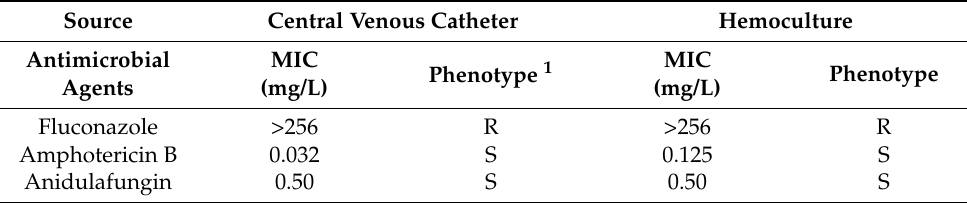
Table 2. Candida parapsilosis isolate susceptibility to antimicrobials. Source Central Venous Catheter